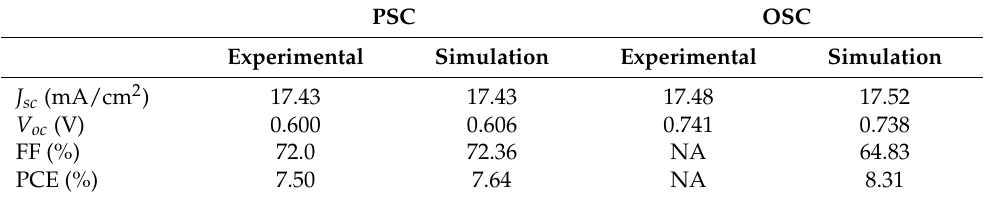
Figure 3. Illuminated J-V characteristics obtained by fitting of the experimental with the SETFOSS model: ( a ) PSC and ( b ) OSC. Table 1. PV parameters of both experimental and simulated PSC and OSC structures under AM1.5G illumination.